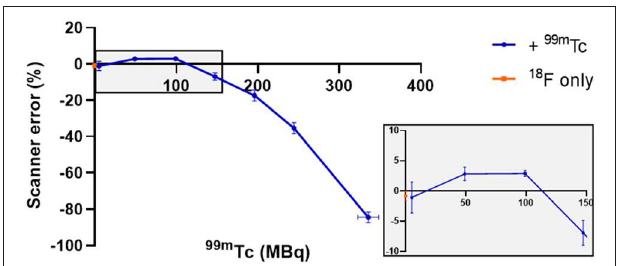
FIGURE 1 | Effect of different amounts of 99m Tc on the accuracy of PET scanner quantification of 5 MBq 18 F. The effect on scanner quantification was assessed by comparing the amount of 18 F measured by the dose calibrator to that measured by the PET scanner; n = 3, mean ± SD. Gray box inset provides zoom of 0–150 MBq region.